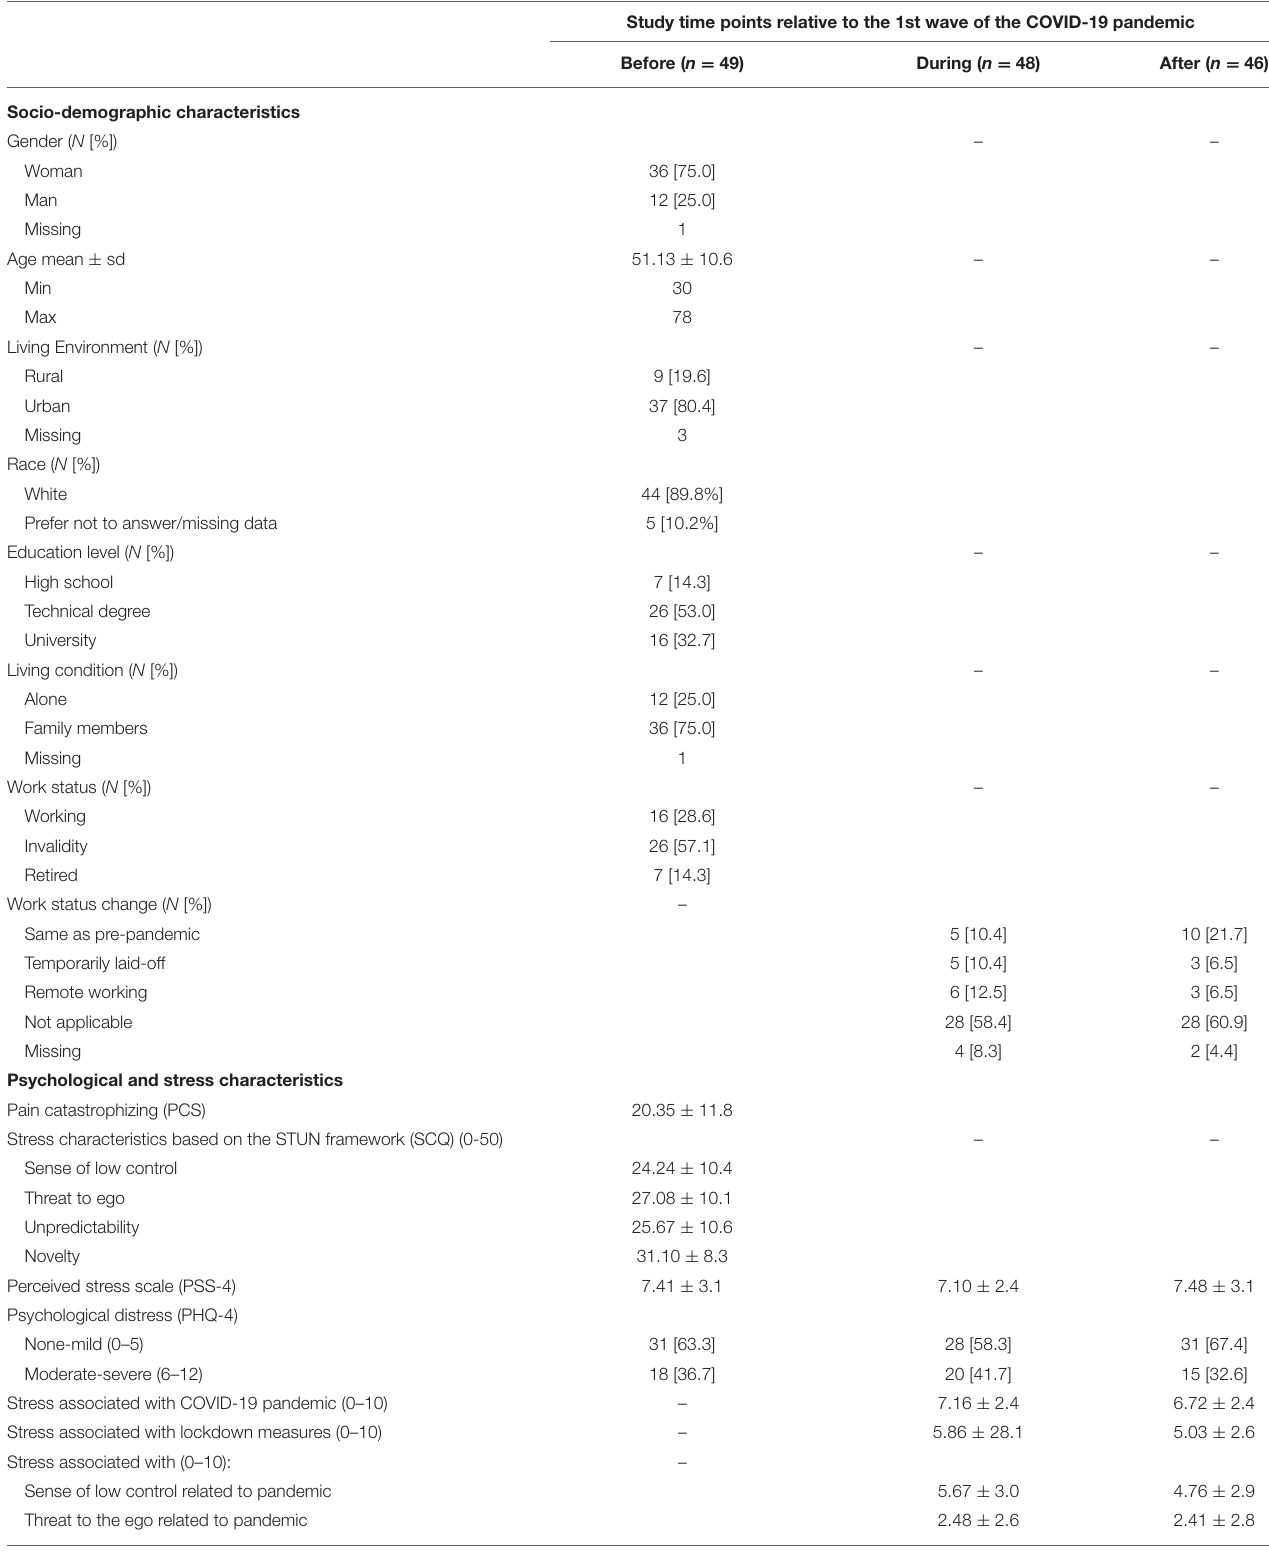
TABLE 1 | Socio-demographic, pain, stress and psychological characteristics of individuals living with chronic pain before, during and after the first wave of the COVID-19 pandemic. Study time points relative to the 1st wave of the COVID-19 pandemic Before ( n = 49) During ( n = 48) After ( n =